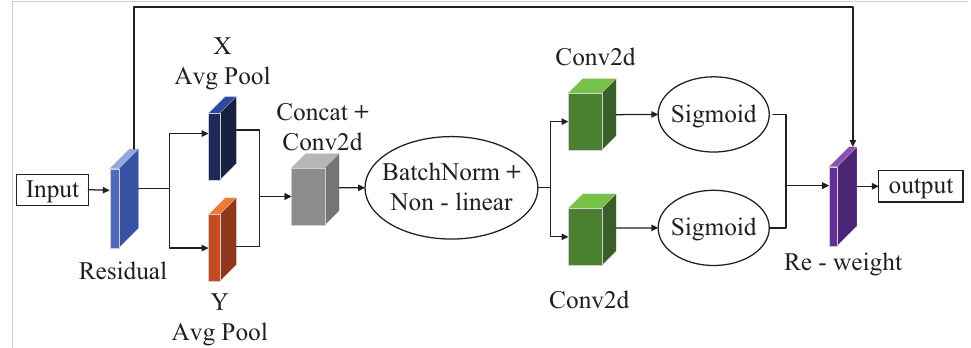
Figure 4. Structure of the CA attention module.